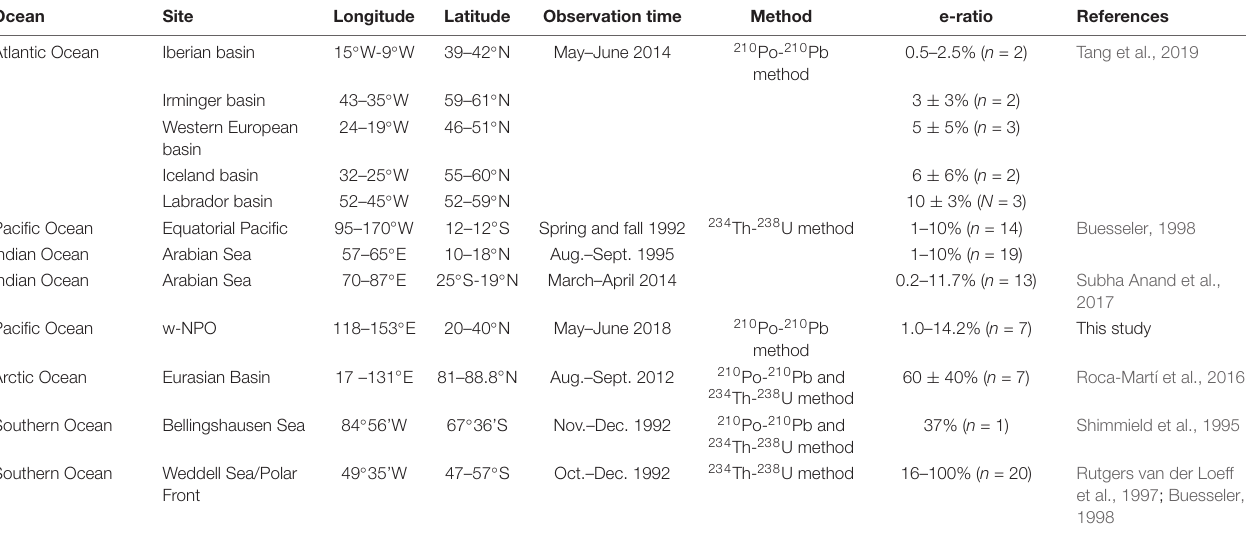
TABLE 5 | Summary of carbon export efficiencies ( e-ratios ) based upon 210 Po or 234 Th approach in global open oceans.